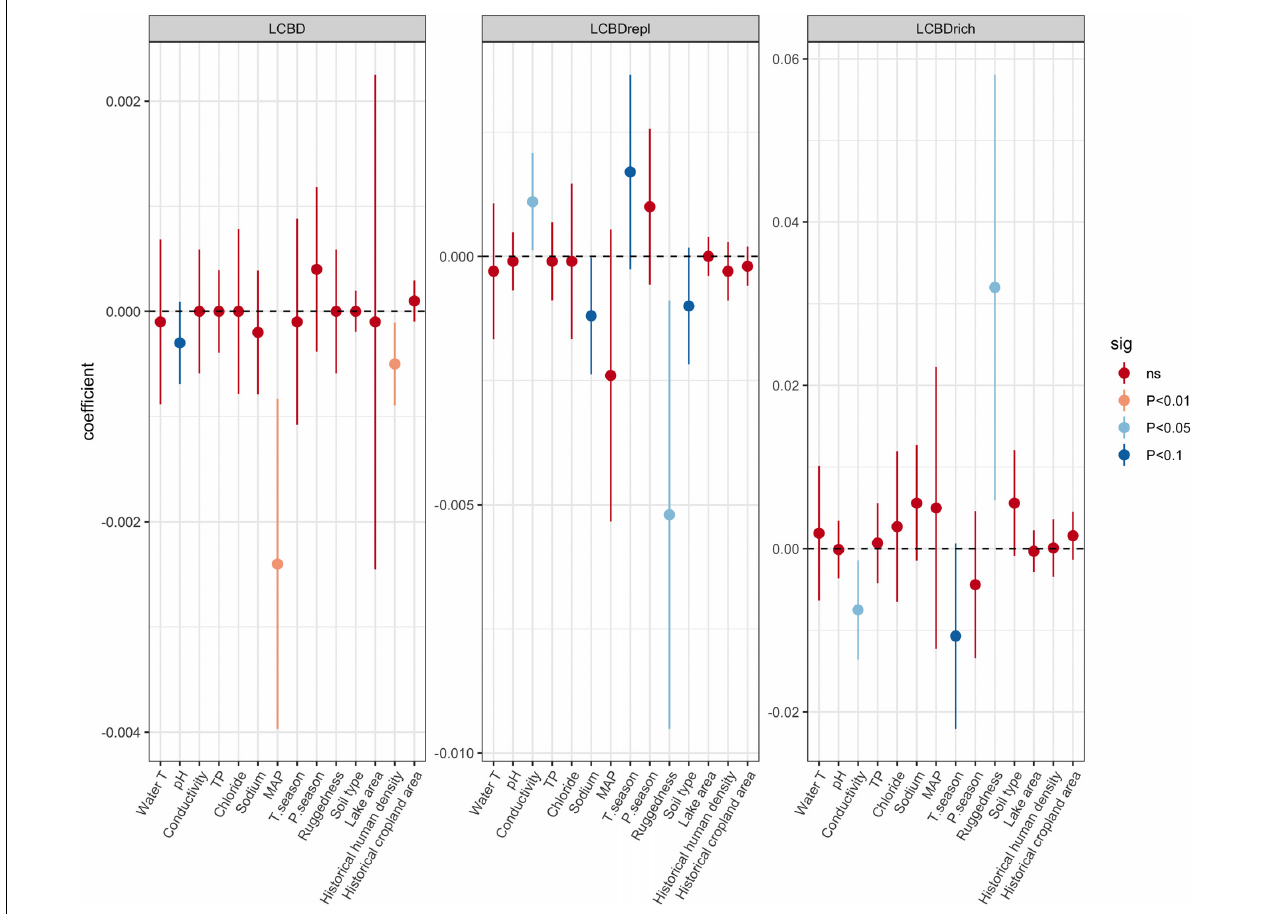
FIGURE 2 | Effect of predictors on local contributions to beta diversity (LCBD) and to the replacement (LCBDrepl) and richness (LCBDrich) components, estimated as linear coefficients from Generalized Additive Models. Errors bars are ± 95% confidence intervals. Colors indicate the significance level α = 0.05.